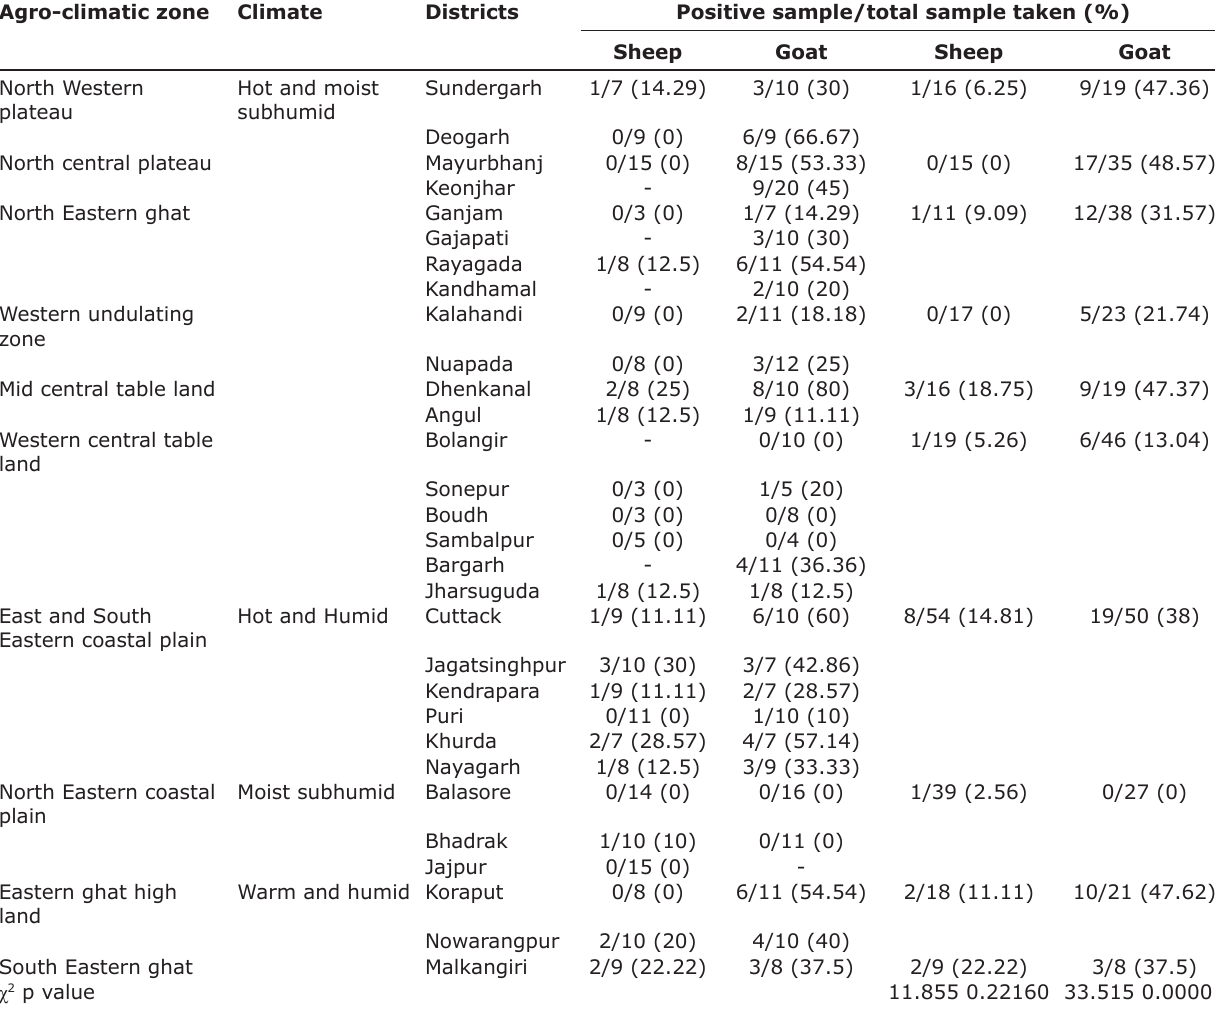
Table-2: Seroprevalence of Capripoxvirus infection in sheep and goats based on agro-climatic zones and districts. Agro-climatic zone